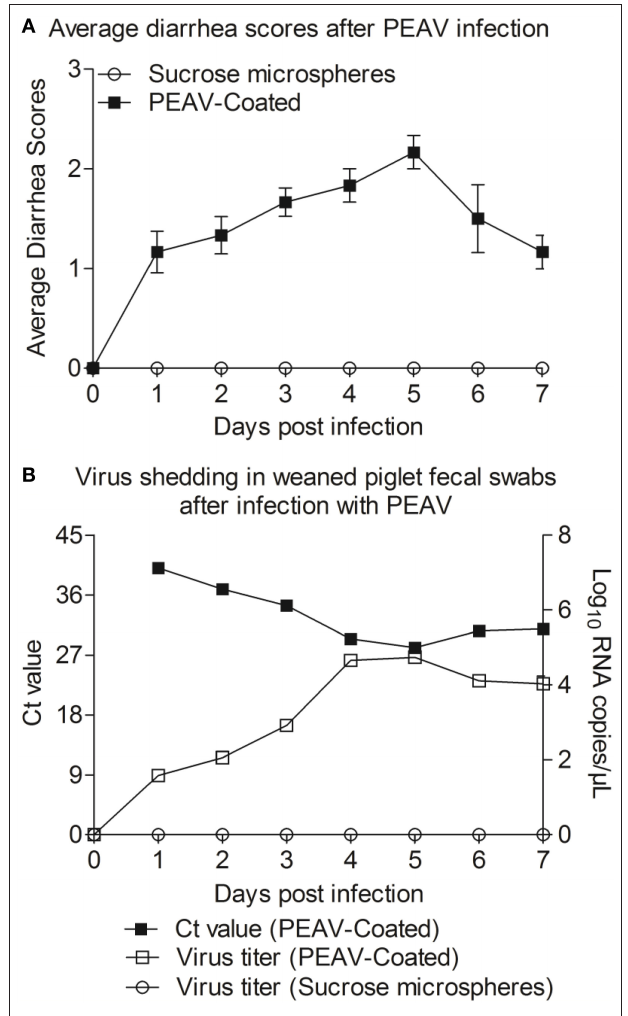
FIGURE 4 | Reproduction of watery diarrhea and fecal viral shedding in weaned piglets inoculated with PEAV-Coated via oral feeding. (A) Average diarrhea scores after PEAV-Coated infection. (B) Ct values of group PEAV-Coated inoculated weaned piglet fecal swabs and viral RNA shedding in fecal swabs after PEAV-Coated inoculation or sucrose microspheres inoculation.